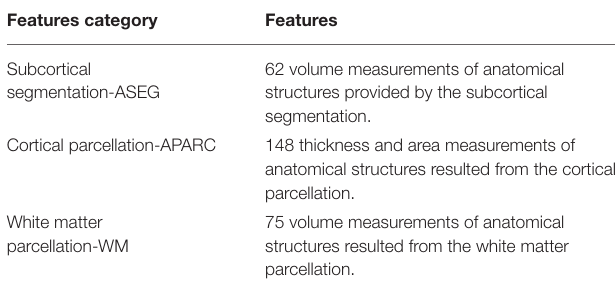
TABLE 2 | Summary of the MRI computed